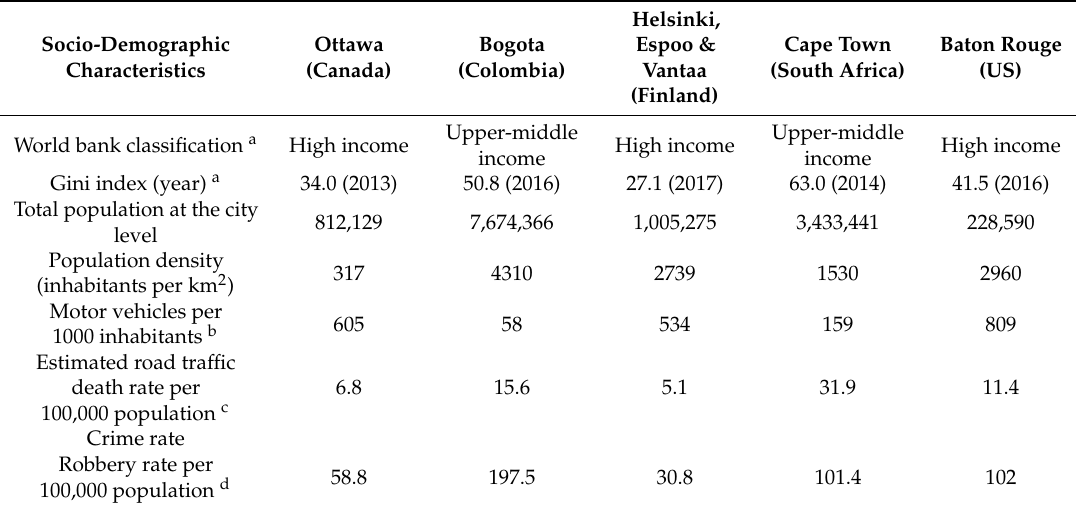
Table 1. Sociodemographic characteristics of five country sites in the International Study of Childhood Obesity, Lifestyle and the Environment